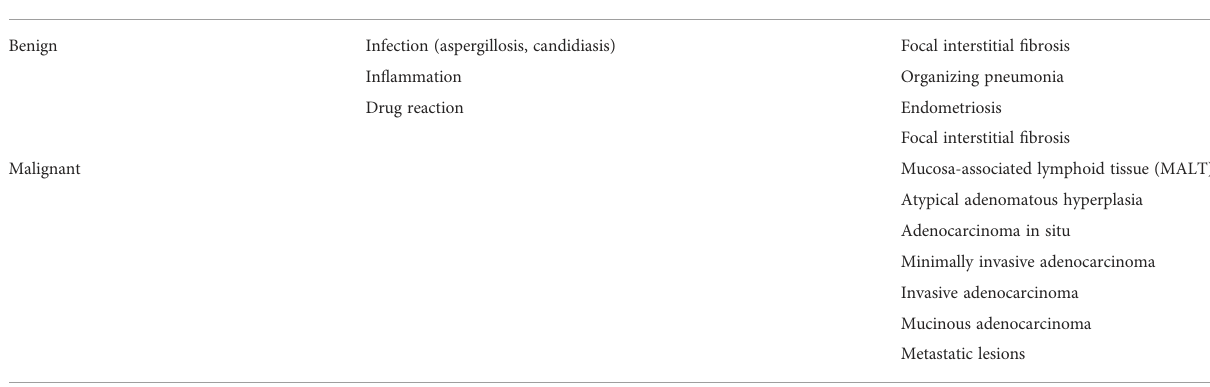
TABLE 1 Differential diagnosis of